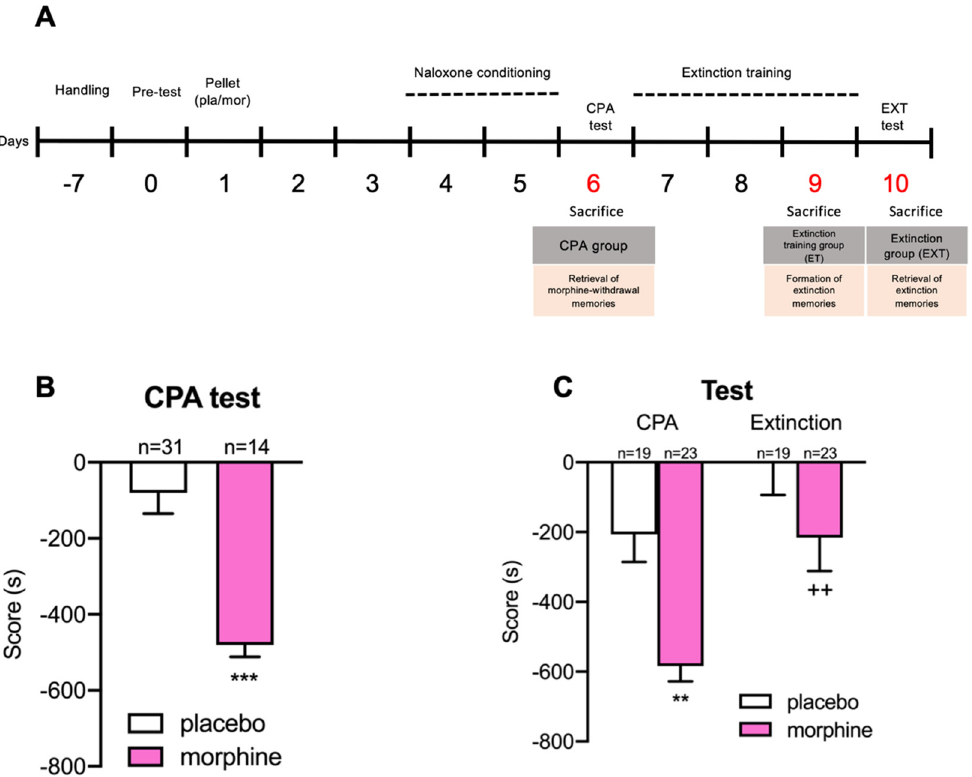
Figure 1. ( A ) Timeline of the behavioural procedures. After 7 days of habituation and handling, on day 0 animals were placed in the central corridor and allowed to explore the apparatus freely for 30 min (pre-test). On day 1, rats were implanted s.c. with 2 morphine or placebo pellets and were let to recover for 3 days. On day 4, for each rat, one chamber was randomly chosen to be paired with naloxone and the other chamber with saline (conditioning sessions). CPA test was conducted on day 6, exactly as in the preconditioning phase. After the test, for 3 days, rats were injected with saline and confined in both chambers. On day 10, rats were tested as in CPA test (extinction test). ( B ) CPA score. *** p < 0.001 vs. P-CPA. ( C ) CPA and extinction scores. ** p < 0.01, *** p < 0.001 vs. P-CPA; ++ p < 0.01 vs. M-CPA. Each bar corresponds to mean ± SEM of the mean.